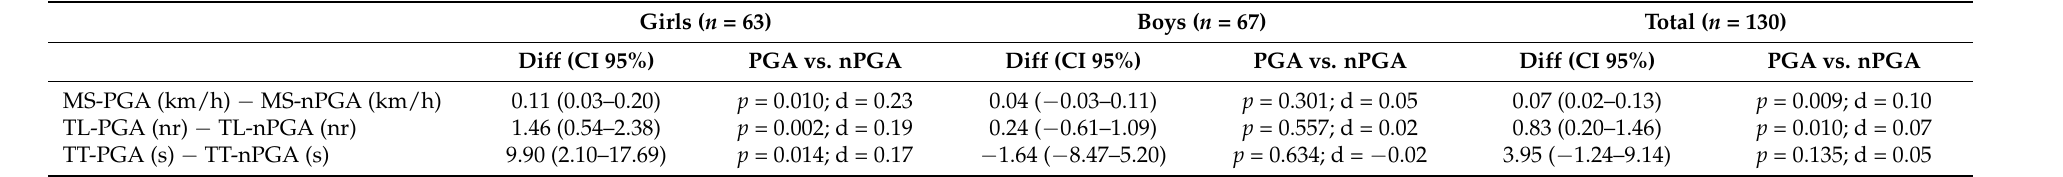
Table 3. Comparison of the 20mSRT performance variables in the two trials with and without the portable gas analyzer.